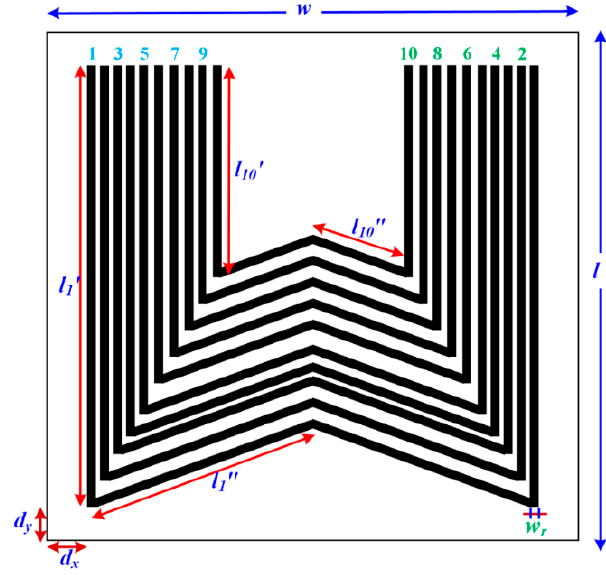
Figure 2. Structure of the proposed M-strips tag.